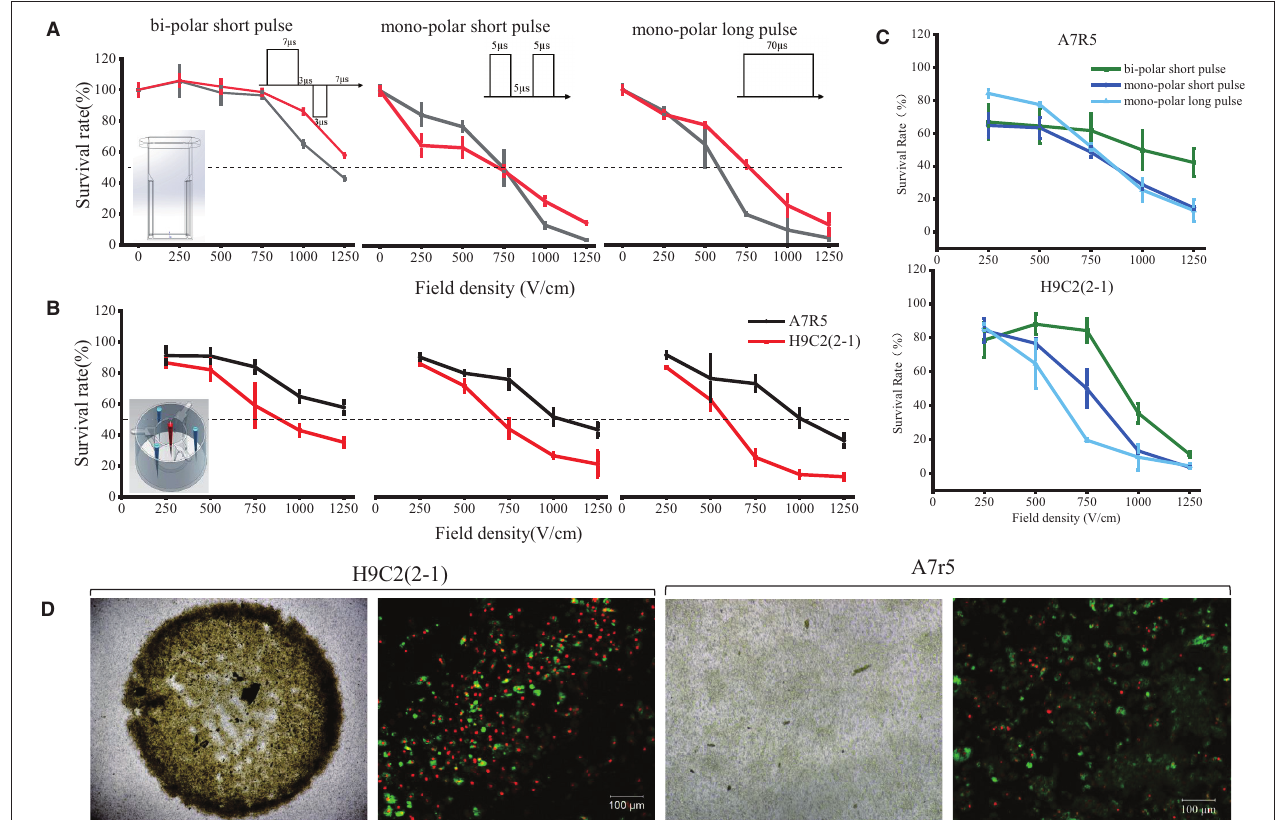
FIGURE 1 | Dose–effect curves of PFA for H9C2(2-1) and A7r5 in single-cell and monolayer systems. (A) PFA on single cells. (B) PFA on monolayer cells. (C) Comparison of cell killing efficiency of three pulsed modes of PFA. (D) The morphologic change of cell monolayer after PFA. The top row shows the images under × 4 magnification; the bottom row shows the results of live/dead cell staining under × 10 magnification. PFA, pulsed-field